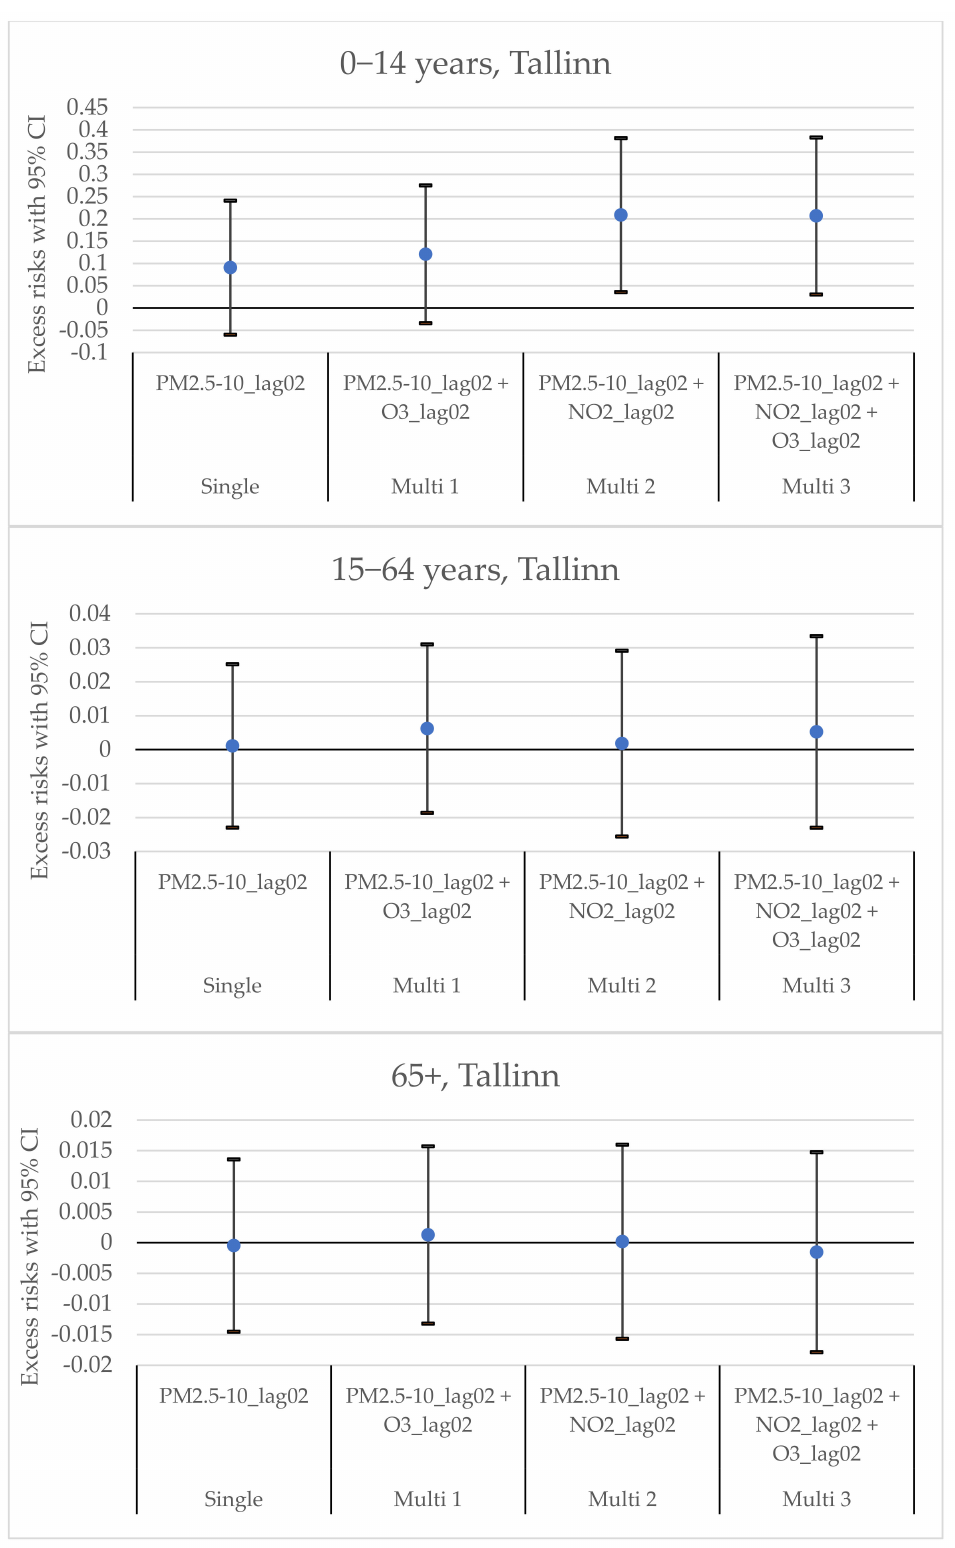
Figure 4. Multi-pollutant models of the estimated change in daily mortality in different age groups (with 95% CI) for an IQR increase in the concentration of PM 2.5–10 (lag02) in Tallinn. From left to right: a single-pollutant estimate of PM 2.5–10 (Single), PM 2.5–10 adjusted for O 3 (Multi 1), PM 2.5–10 adjusted for NO 2 (Multi 2), and PM 2.5–10 adjusted for both NO 2 and O 3 (Multi